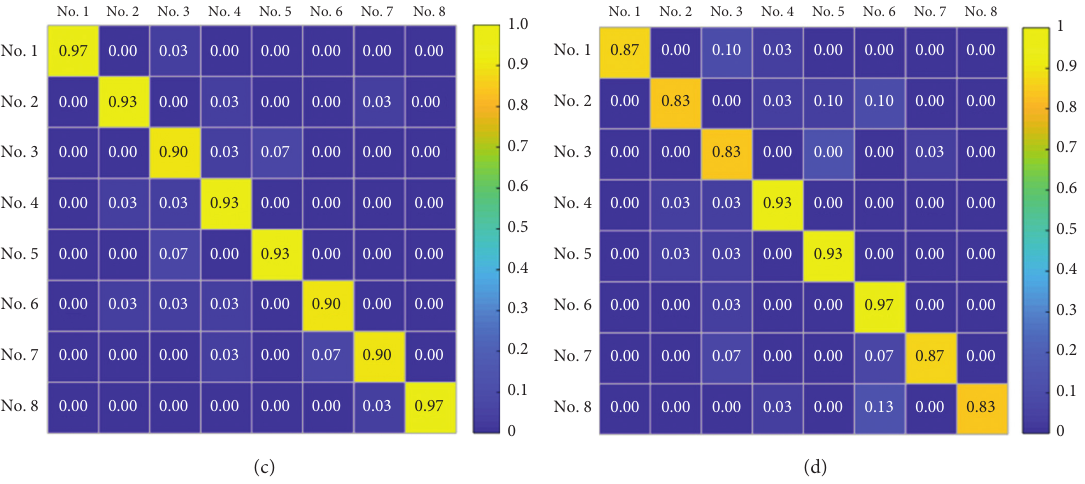
Figure 16: Comparison with related works. (a) Results by WP-ILBP-NNC with mean accuracy of 0.9667. (b) Results by WP-ILBP-SVM with mean accuracy of 0.9583. (c) Results by WVD-FCBF-RVM with mean accuracy of 0.9288. (d) Results by VMD-bi spectrum with mean accuracy of